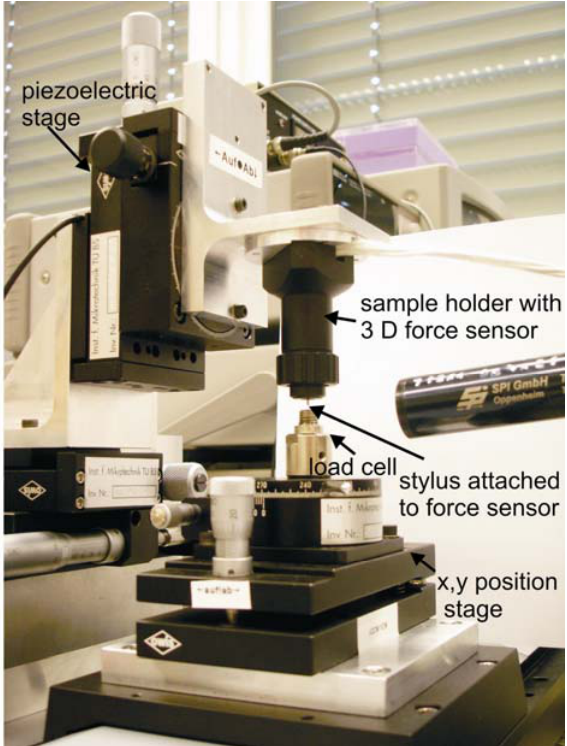
Figure 3 . Set-up used for the